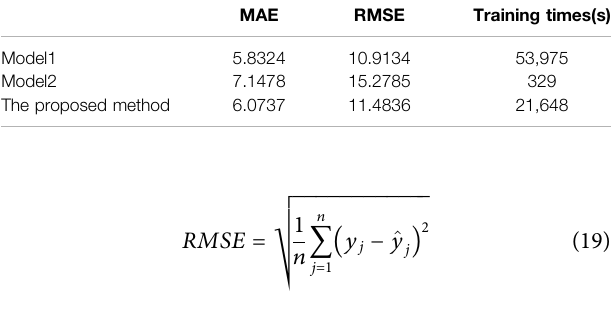
TABLE 2 | BAA performance based on different ROIs. Training Testing